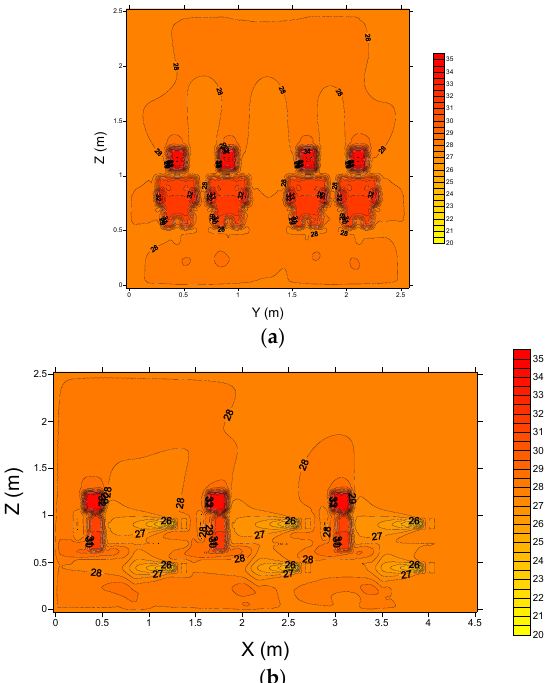
Figure 11. Air temperature field in the virtual classroom with 12 occupants in the plans ( a ) X = 1.791 m and ( b ) Y = 0.4423 m, with an inlet air temperature of 24 °C.